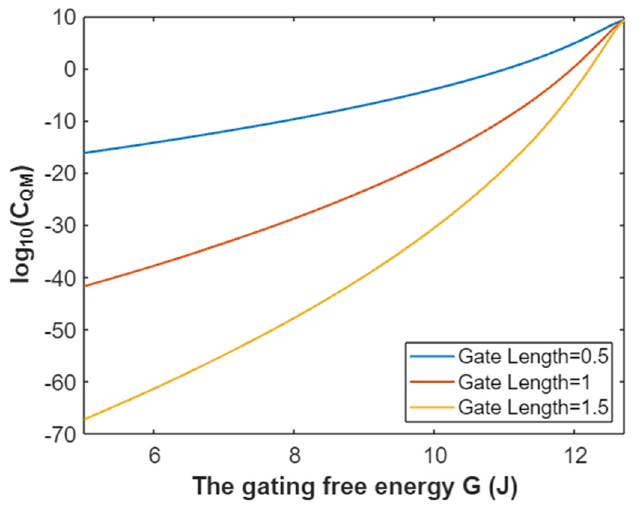
Figure 32. The relationship between gating free energy and the common logarithm of the quantum membrane conductance of intracellular potassium ions at membrane potential of 0.087 V and over a gating free energy range from 5 J and 12.72 J.